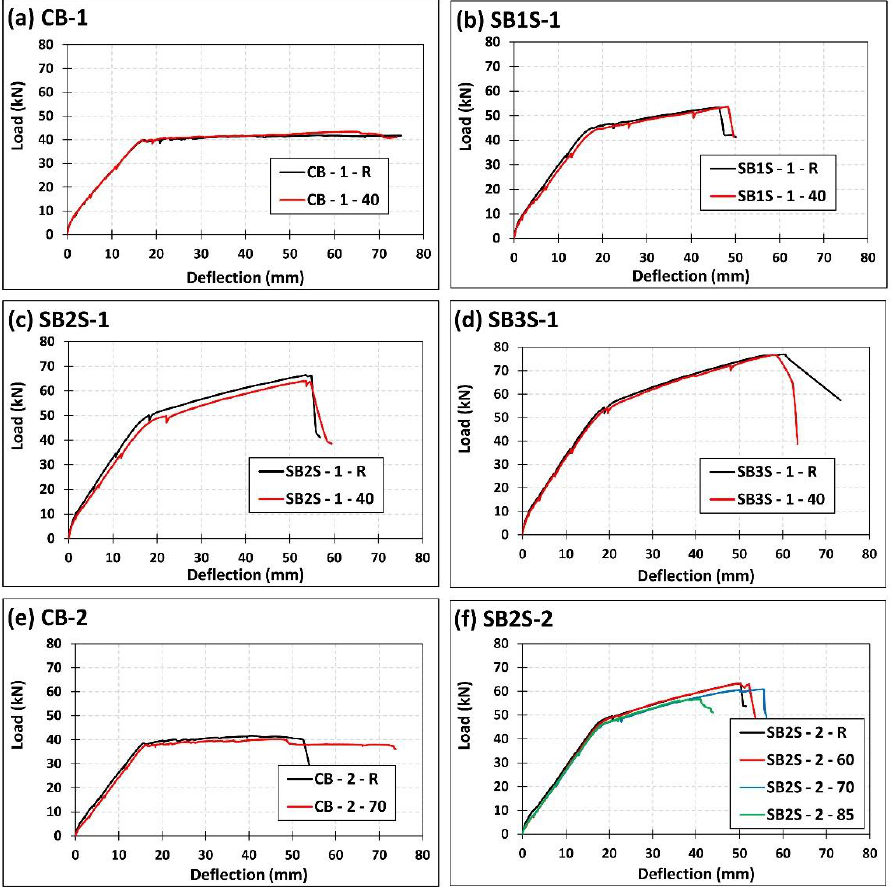
Figure 9. Effect of temperature on the experimental load–deflection curves of specimens ( a ) CB-1;